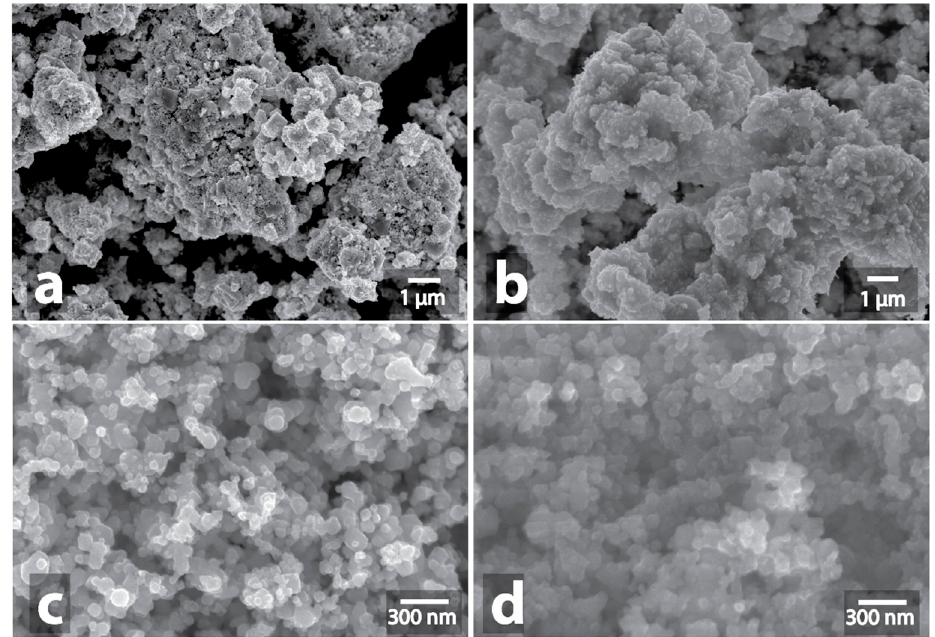
Figure 8. SEM image of initial WC powder ( a ) and SEM image of WC powder after MW-treatment ( b ), initial TiC powder ( c ) and SEM image of TiC powder after MW-treatment ( d ).